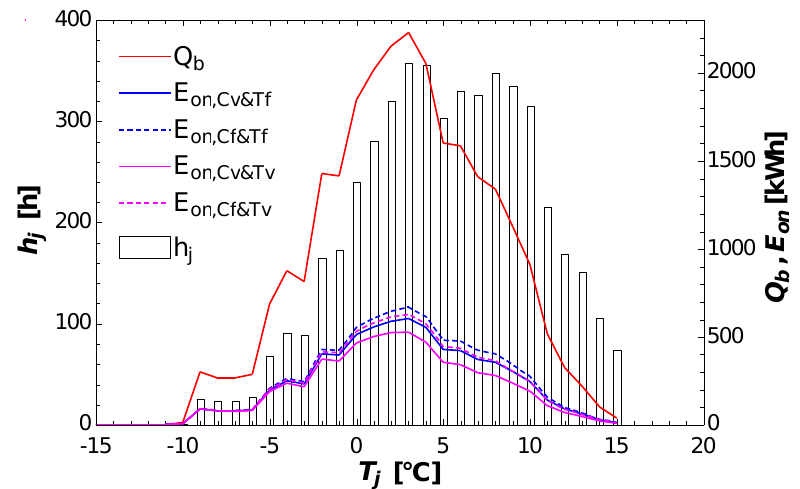
Figure 6. Heating demand and energy consumption distribution under the average climate season for the four different heat pump options.